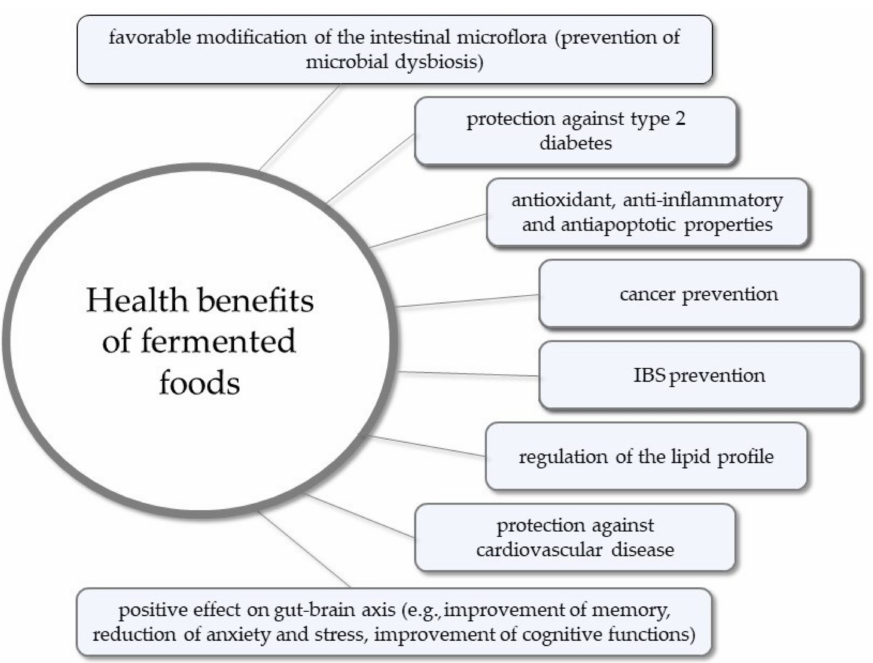
Figure 2. Health benefits of consuming fermented